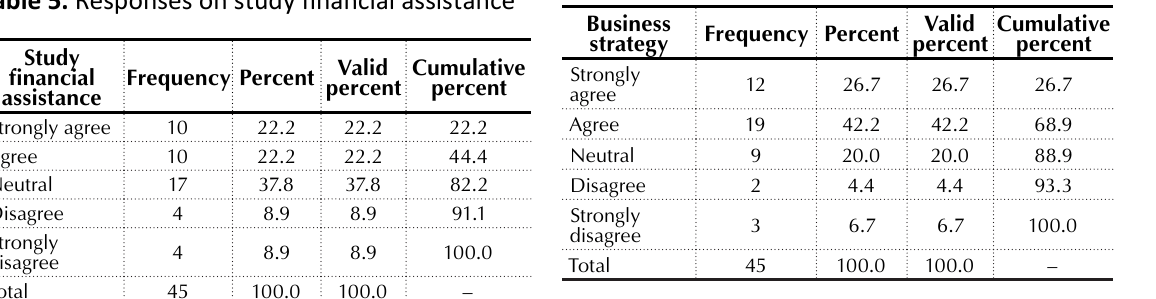
Table 8. Responses on business